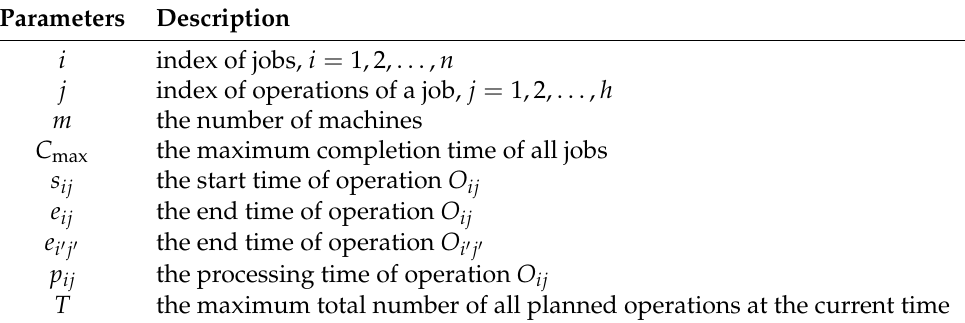
Table 1. DJSSP specific parameters table.